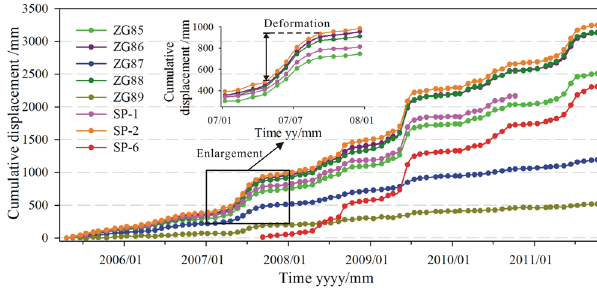
Figure 4. The GPS monitoring data of the Shuping landslide.